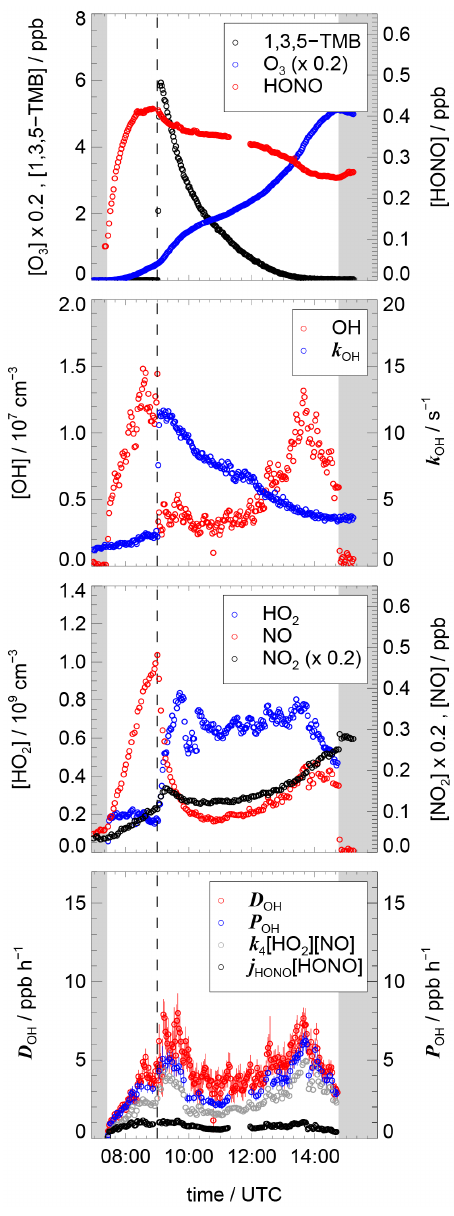
Figure 1. Measurements of selected quantities performed during a low-NO SAPHIR experiment with 1,3,5-TMB on 17 June 2010. Grey shaded areas indicate time periods when the chamber roof was closed. Formation of HONO, the major OH precursor in SAPHIR, was observed by LOPAP just after the humidified chamber was ex- posed to sunlight (red points, upper panel). The injection of 1,3,5- TMB, marked by the vertical dashed line, was observed by PTR- TOF-MS (black points, upper panel) and the OH reactivity instru- ment (blue points, second panel). OH and NO rapidly decreased whereas HO 2 increased after the 1,3,5-TMB addition (middle pan- els). Diurnal profiles of P OH and D OH (lower panel) were calcu- lated according to Eqs. (2) and (3). Other data in the lower panel show the main terms contributing to P OH